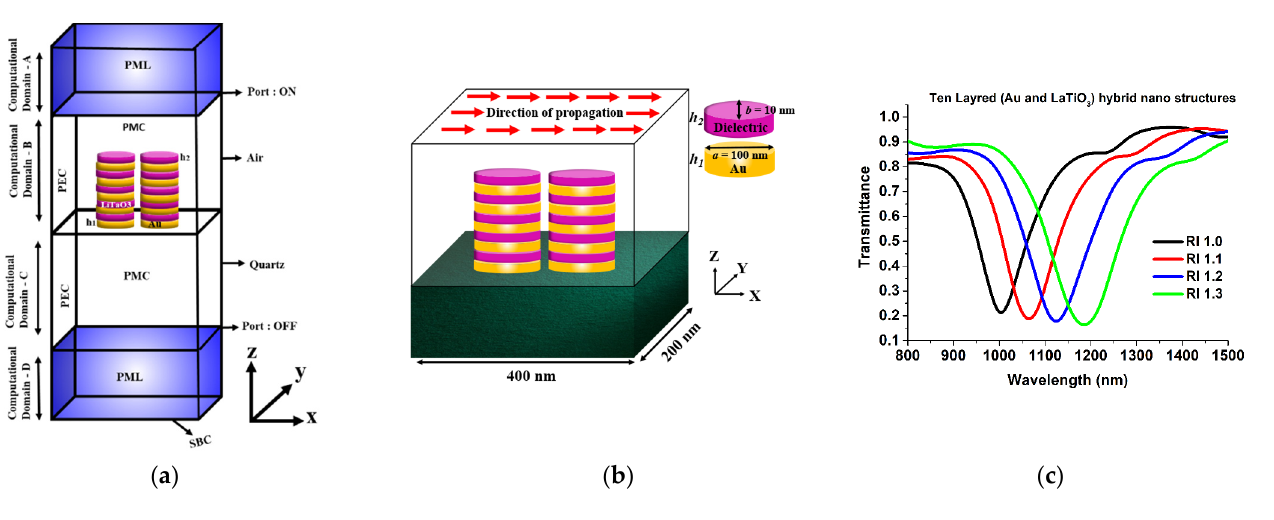
Figure 1. ( a ) Schematic of the computational domain designed on the FEM method enabled commercial software ( b ) Graphical representation of the designed hybrid refractive index sensor ( c ) Transmission spectra of the optimized paired elliptical nano structure with major axis, a = 100 nm and minor axis, b = 10 nm.